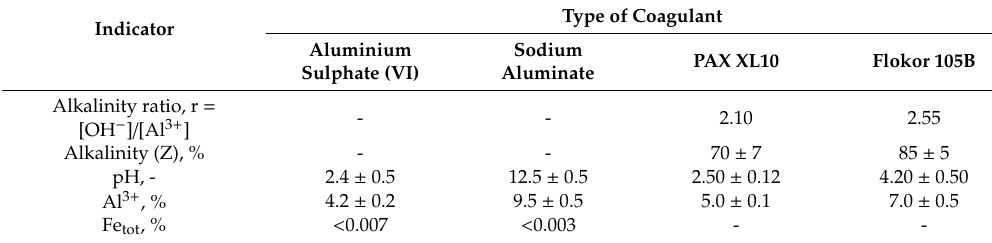
Table 1. Selected properties of the coagulants tested (Manufacturer’s